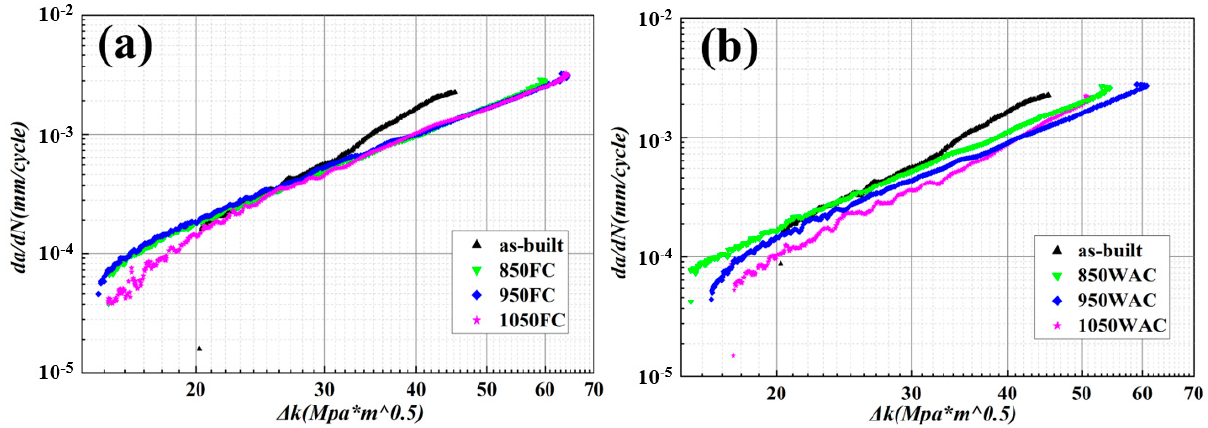
Figure 11. Comparison of CGR curves on different AT specimens: ( a ) and AST specimens: ( b ).